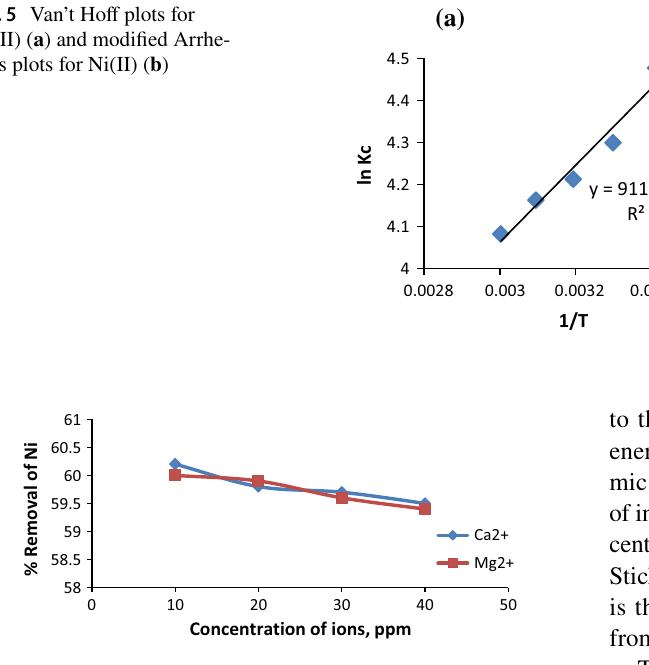
Fig. 6 Interference studies of the biosorption of Ni